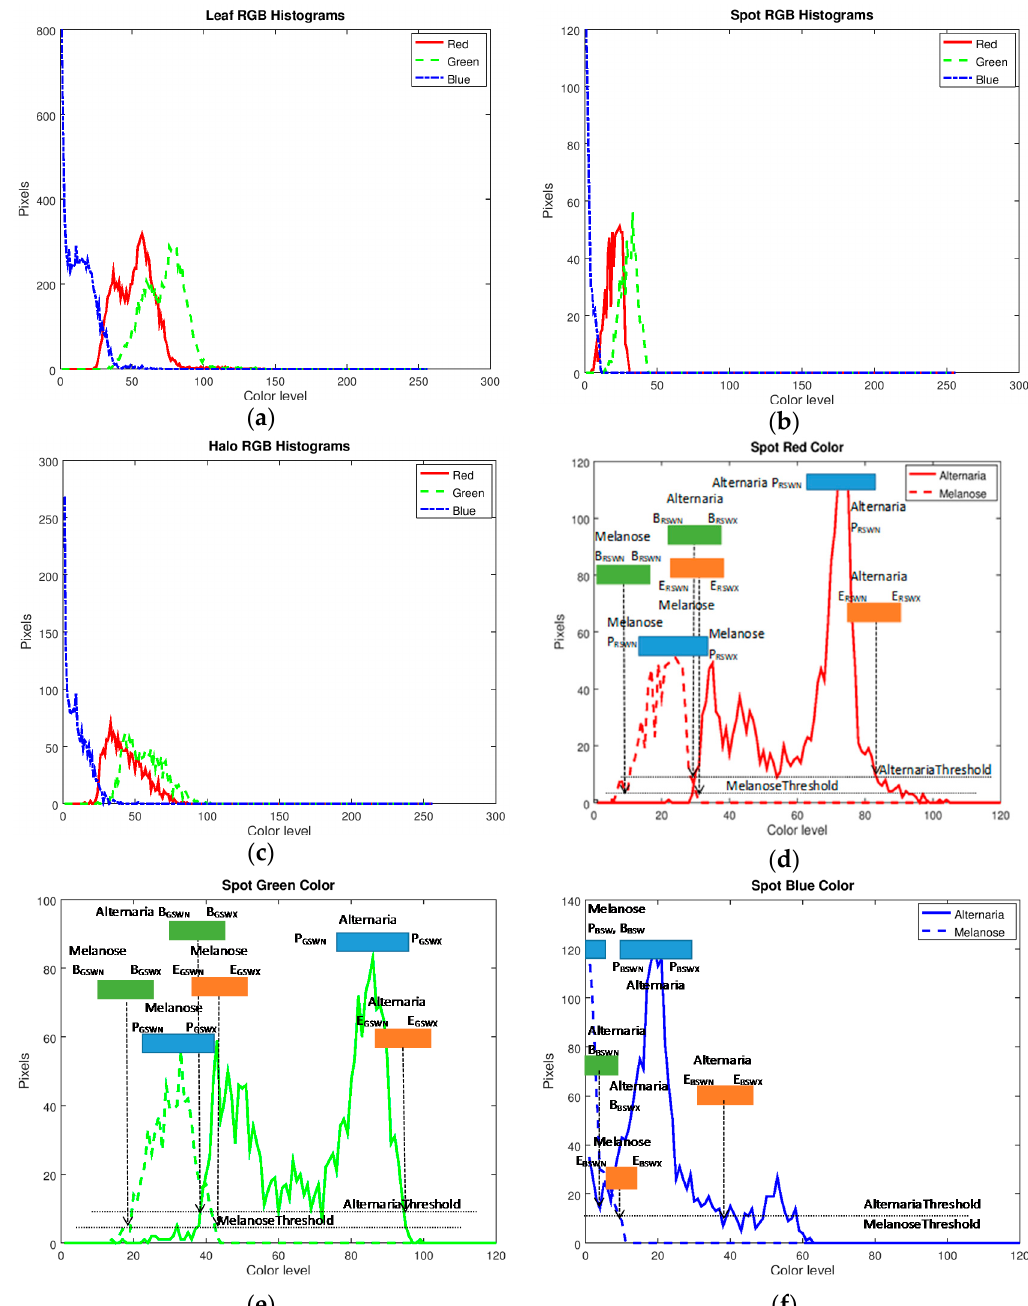
Figure 5. Red-green-blue (RGB) color histograms for the leaf ( a ), the spot ( b ) and the halo ( c ) of Figure 3a image. Feature comparison between melanose and Alternaria spots: red ( d ), green ( e ) and blue ( f ) color.